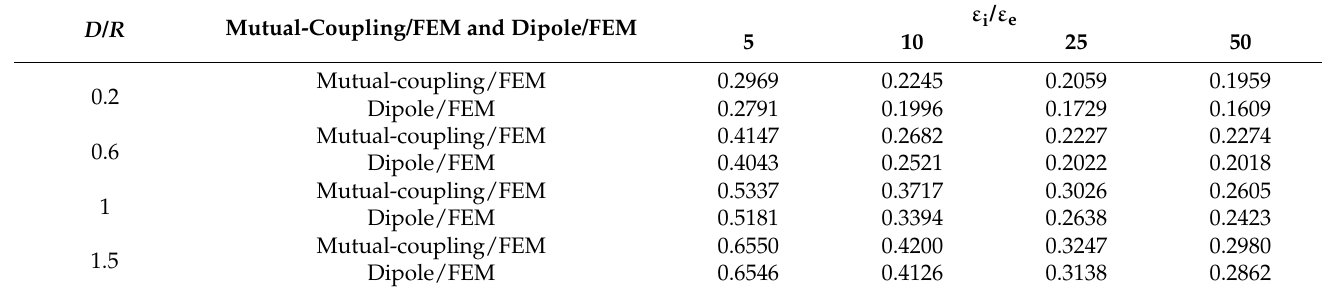
The similarity of the curves under a longitudinal external electric field (mutual- coupling/FEM and